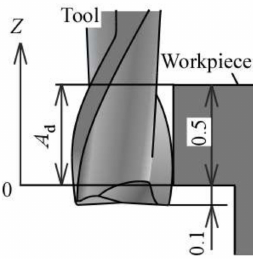
Figure 1. Interference situation between the workpiece and the tool.